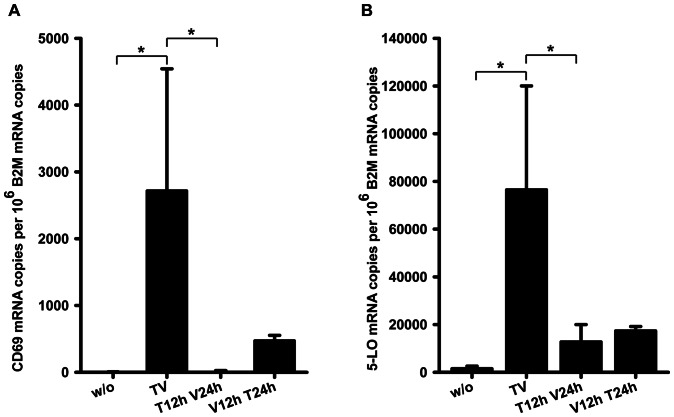
Effects of sequential treatment with TGF-β and 1α,25(OH)2D3.(A and B) THP-1 were treated with (TV) or without (w/o) 1 ng/ml TGF-β and 50 nM 1α,25(OH)2D3 for 24 h or pretreated for 12 h with either 1 ng/ml TGF-β (T12h V24h) or 50 nM 1α,25(OH)2D3 (V12h T24h), washed with PBS and subsequently treated with the respective other compound for another 24 h. CD69 and 5-LO mRNA levels were determined by qPCR. Statistical analysis was conducted with one way ANOVA and Bonferroni's post test (*P<0.05).